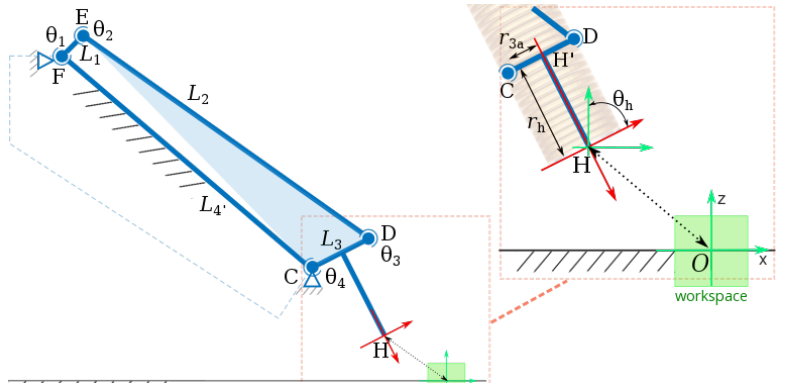
Figure A1. Representation of the robotic arm’s kinematic chain with the four links L 1 – L 4 and joints θ 1 – θ 4